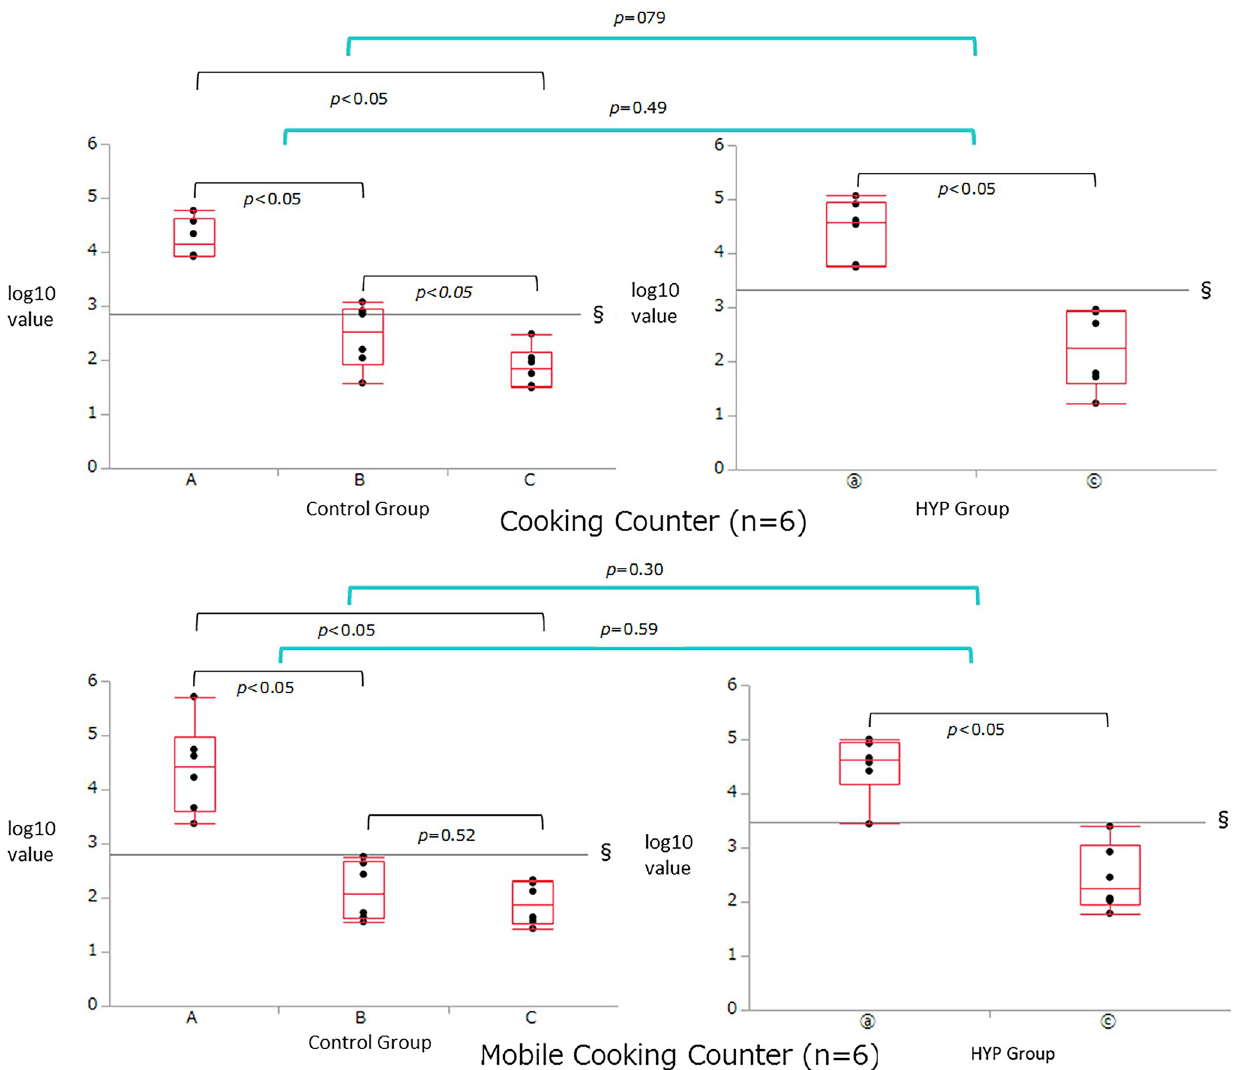
Fig 2. Inter-group comparison of the relative light unit (RLU) and log 10 values in the cooking counter and mobile cooking counter test locations measured by adenosine triphosphate (ATP) swab testing. There were significant improvements in the log 10 values of the RLUs from the pre-disinfecting (A) to post-surfactant swab (B) and post-HYP swab (C) for the control group, and from the pre-disinfecting ( ⓐ ) to post-HYP swab ( ⓒ ) for the HYP group ( p < 0.05). There was no significant difference in the log 10 value of RLU values between the post-surfactant swab (B) and post-HYP swab (C) for the control group at the mobile cooking counter. ( p = 0.52); however, differences were observed at these time points for the control group at the cooking counter. In both these locations, there were no significant differences in the changes in the logarithmic RLU values between the post-HYP swab ( ⓒ ) of the HYP group and the post-surfactant swab (B) and post-HYP swab (C) of the control group.